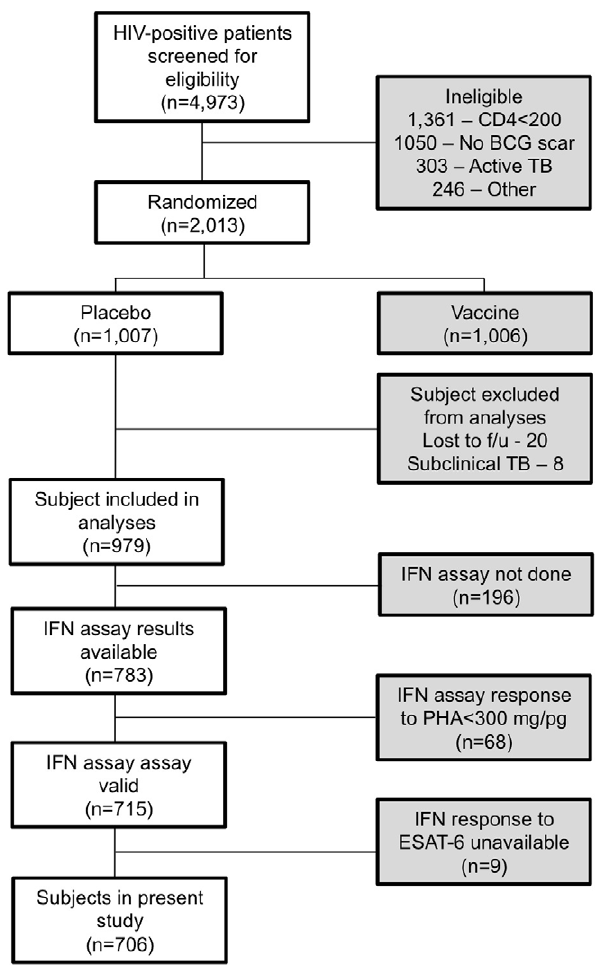
Figure 2. Fraction of subjects who developed HIV-associated tuberculosis (TB) according to the number of baseline interferon gamma (IFN- c ) responses detected against myco- bacterial preparations.